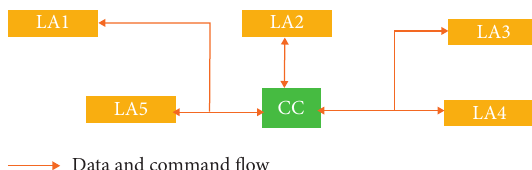
Figure 1: Centralized control architecture. All local area networks or microgrids in the main network are controlled by a centralized controller.